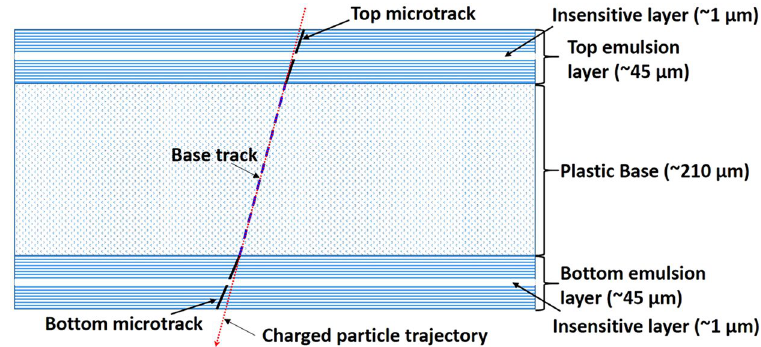
Figure 1. Passage of a charged particle through an OPERA-like emulsion